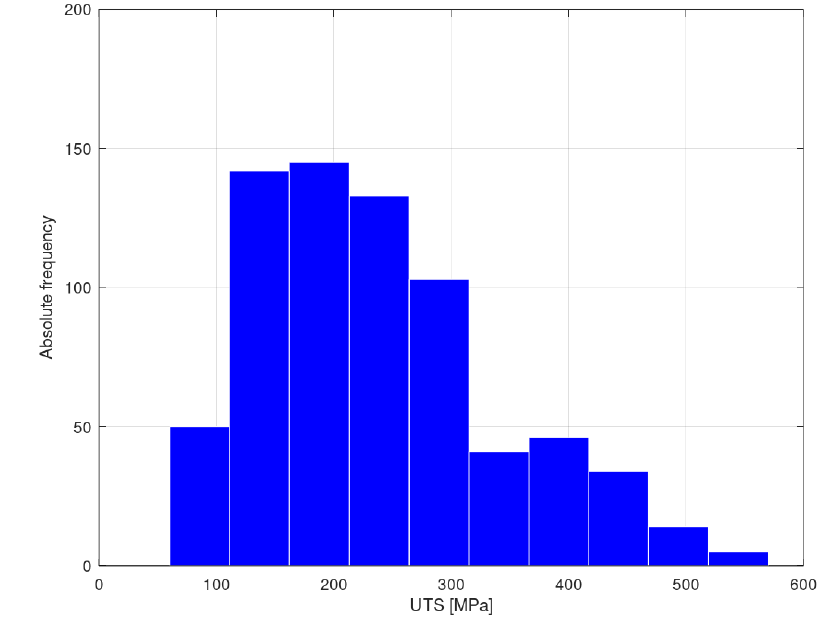
Figure A3. Ultimate tensile strength histogram of the input dataset.